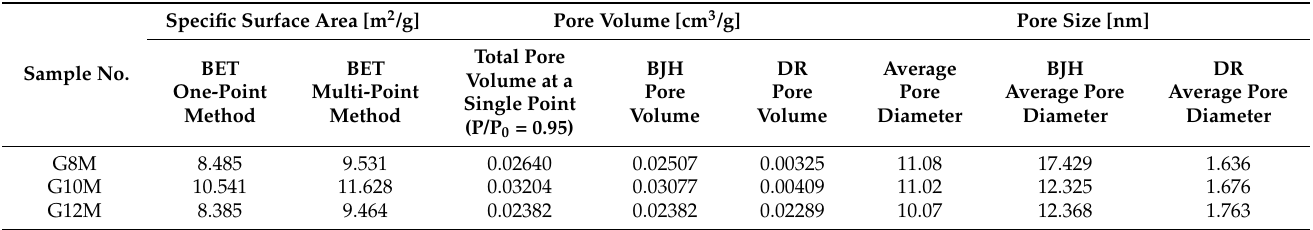
Table 8. Results from geopolymer physical sorption analysis after three years of ageing and resoaking in distilled water and drying.